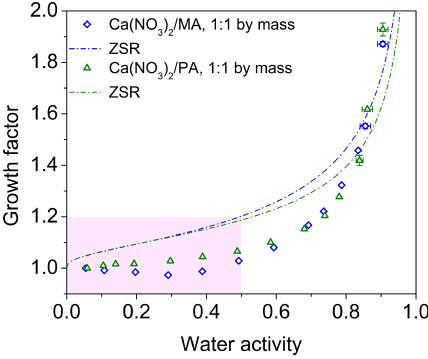
Figure 5. Hygroscopic growth factors of 100nm internally mixed particles composed of Ca(NO 3 ) 2 with malonic acid (MA) or ph- thalic acid (PA) at equal mass ratios as a function of water activity. The blue and green dashed dotted lines indicate the hygroscopic growth predicted from the ZSR method. The error bars representing the standard deviation of multiple measurements are not obvious compared to the size of the symbols. The shaded area shows no significant water uptake by the mixed systems under low RH con-